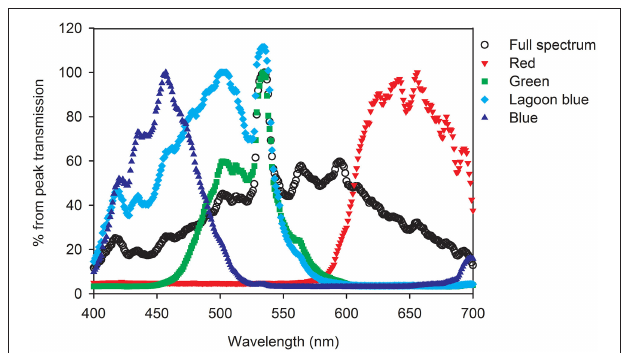
FIGURE 1 | Spectrum of the Metal halide lamp (Full spectrum control) and the transmission spectra through red, green, “lagoon” blue, or blue filters, calculated as percent relative to the peak